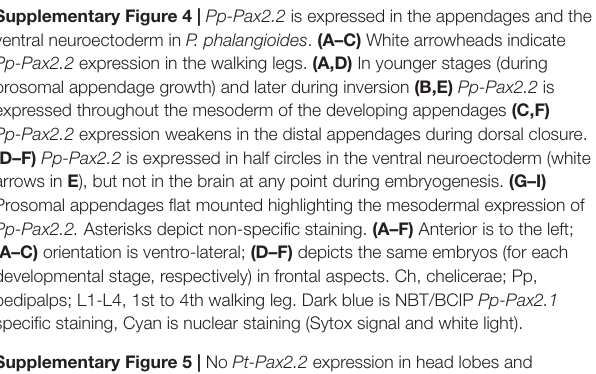
Supplementary Figure 5 | No Pt-Pax2.2 expression in head lobes and appendages during very early brain differentiation (onset of stage 10). Neural invagination sites are clearly visible in head lobes (A) and VNE (B) . No expression can be detected in head lobes (A’) . (A,B) Is nuclear DAPI staining, (A’,B’) is FAST RED signal (no signal) staining Pt-Pax2.2. (A”,B”) Are overlays of (A,A’,B,B’) , respectively. Supplementary Figure 6 | Whole mount embryos showing Pt-poxn ( aug3.g26228 ) expression. Pt-poxn is expressed in the VNE of opisthosomal segments, starting in the first two opisthosomal segments during brain differentiation (stage 10) (white arrows in A,D ). During inversion and retraction (stage 11 and 12) Pt-poxn is expressed as small dots in the VNE of each opisthosomal segment which continues during dorsal and ventral closure (C,F) . Ch, chelicerae; Pp, pedipalps; L1-L4, 1st to 4th walking leg. Dark blue is NBT/BCIP Pt-poxn specific staining, Cyan is nuclear staining (Sytox signal and white light). Supplementary Figure 7 | Separated Z-projections of Pt-Pax2.1 expression during brain differentiation (Stage 10). Red ellipses mark Pt-Pax2.1 expression domains in the eye primordia white dotted line marks the anterior furrow in the head lobes for orientation. Left panels (A–A”) show the upper anterior half of the same embryo as shown in Figure 3A Pt-Pax2.1 is expression is visible in the developing lateral eye primordia next to the lateral furrow (red ellipse) and in proximal and distal spots in the appendages (arrowheads). (B–B”) Same embryo as in Figures 3A–A” this time the lower half Z-stack was projected to visualize Pt-Pax2.1 the expression in the VNE (arrows). Flat mounted preparations; anterior is to the left in all panels. Cyan is nuclear DAPI staining; magenta is Pt-Pax2.1 specific expression detected with FAST RED. Scale bar represents 50 µ m. Supplementary Figure 8 | Unrooted 50% majority rule consensus tree calculated by MrBayes. For this phylogenetic analysis only alignable regions of the protein sequences of the previously identified chelicerate Pax2 candidates were used (accessible as nexus file in Supplementary Data Sheet 3 ). The Jones amino acid substitution model was used to calculate 18 trees in 2 files of which 14 were sampled after reaching an average standard deviation of split frequencies of 0.00918 after 4,000 generations. Similar to the phylogenetic analysis in Figure 1 , using the full-length protein sequences, this phylogenetic analysis also groups the spider and scorpion Pax2 candidates into two separate arachnopulmonate Pax2 clusters, Pax2.1 , and Pax2.2 . Supplementary Table 1 | List of gene specific primer used to clone gene fragments of Pax2.1 and Pax2.2 of P. tepidariorum and P. phalangioides . Supplementary Table 2 | Full lists of sequence information including species, accession number/Transcript ID and source used for phylogenetic analysis in Supplementary Figures 1, 2 (Sheet1:PAX148) and Figure 1 (Sheet2:PAX65). Ordered for Pax subfamilies indicated by same colour code as in used in Supplementary Figures 1, 2